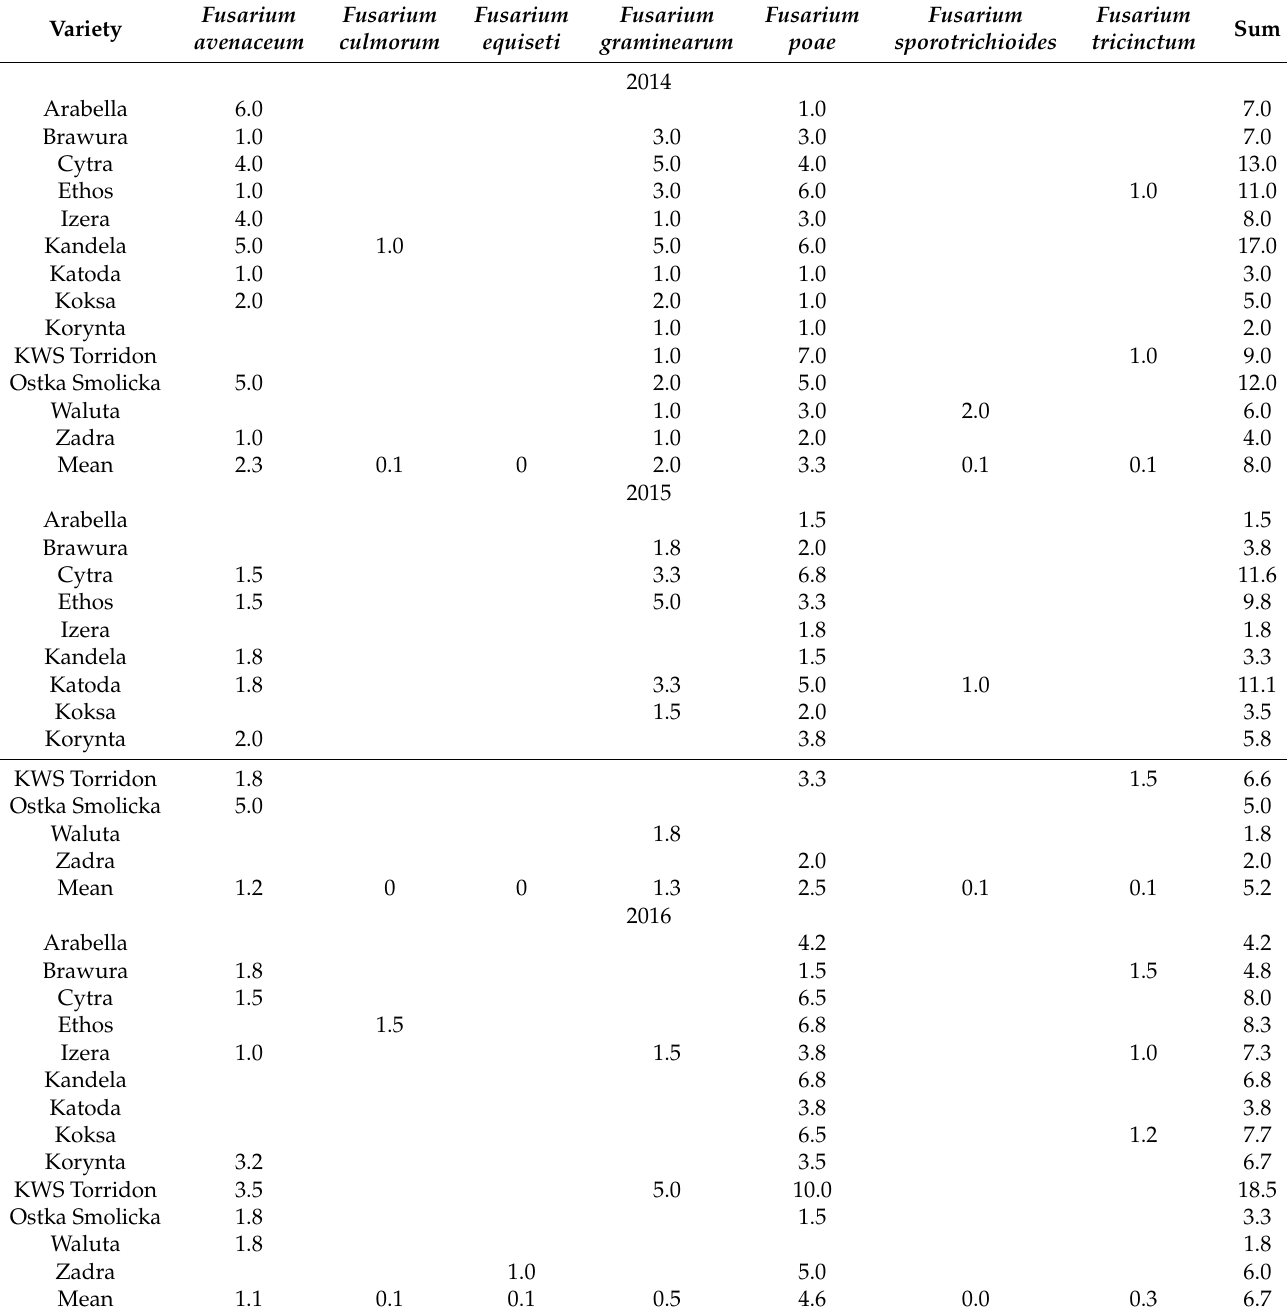
Table 5. Species from Fusarium genus isolated from grains of spring wheat varieties (% of infested grains).